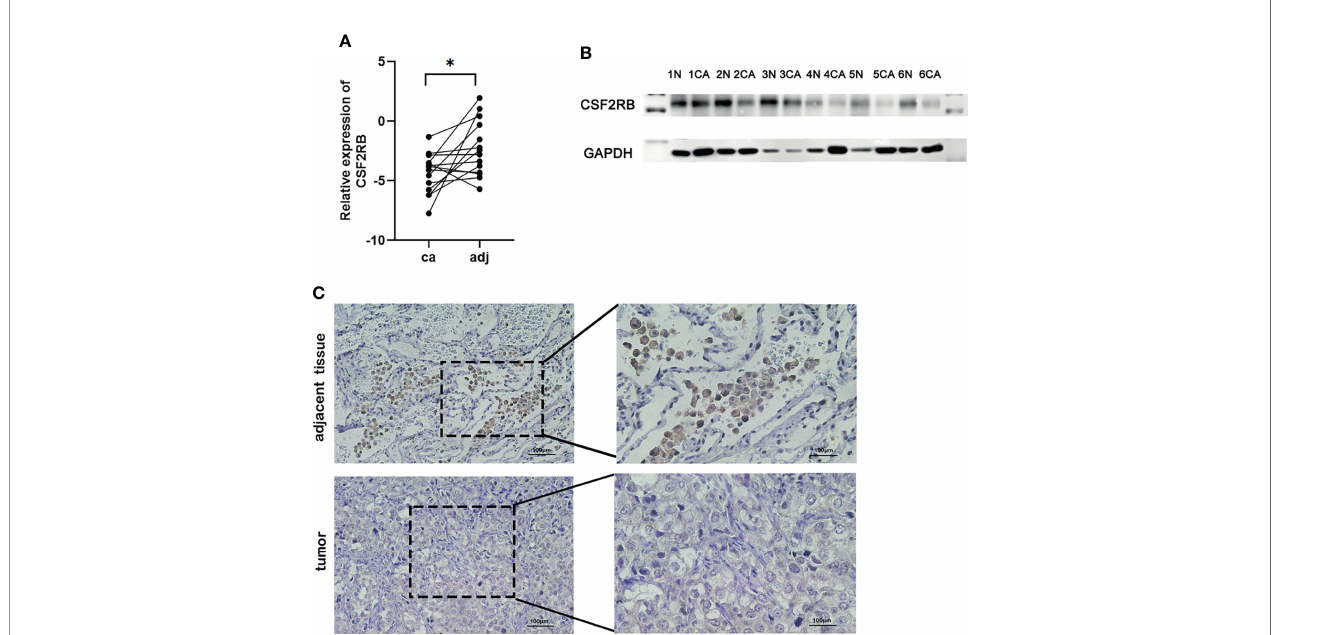
FIGURE 6 | Validate the expression of CSF2RB in lung adenocarcinoma cells. (A) RT-qPCR of CSF2RB. Paired sample expression analyses for the CSF2RB gene. *p < 0.05 (B) CSF2RB expression in LUAD tissues and adjacent normal tissues assayed by Western blot. (C) CSF2RB expression in LUAD tissues and adjacent normal tissues assayed by IHC (×200) and (×400). CA, cancer tissue; N, para-cancer